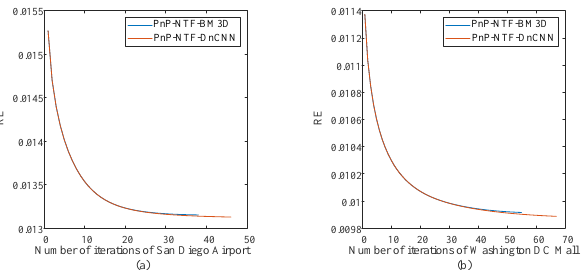
Figure 9. Iterations of RE with the proposed methods on two real hyperspectral datasets: ( a ) number of iterations of San Diego Airport, ( b ) number of iterations of Washington DC Mall .